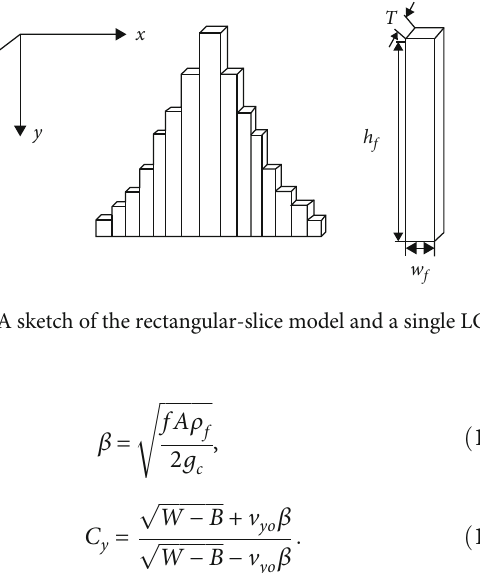
Figure 4: Trajectory of LCM particle fl owing inside a fracture.